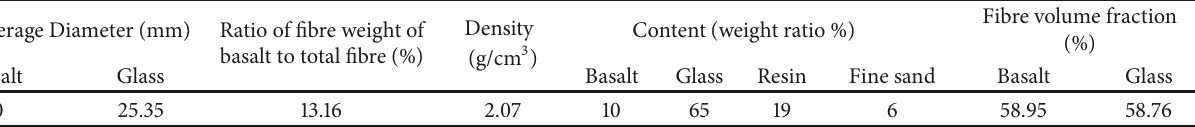
Table 1: Physical properties of FRP bars in study [23].